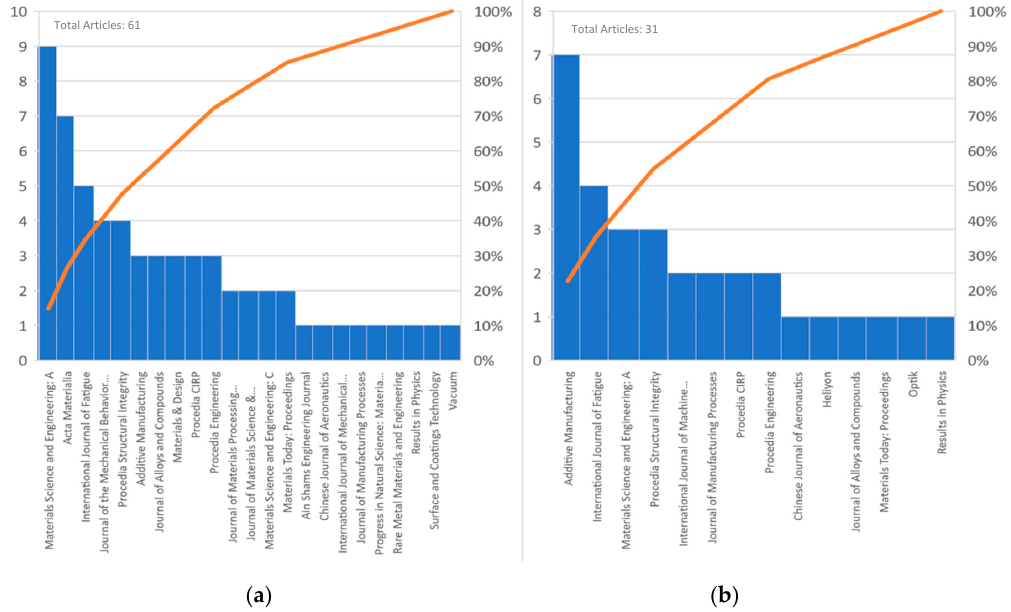
Figure 5. Pareto’s charts of the research, ( a ) “Heat Treatments + Selective Laser Melting + Ti–6Al–4V”, and ( b ) “Residual Stresses + Selective Laser Melting + Ti–6Al–4V”, on ScienceDirect.